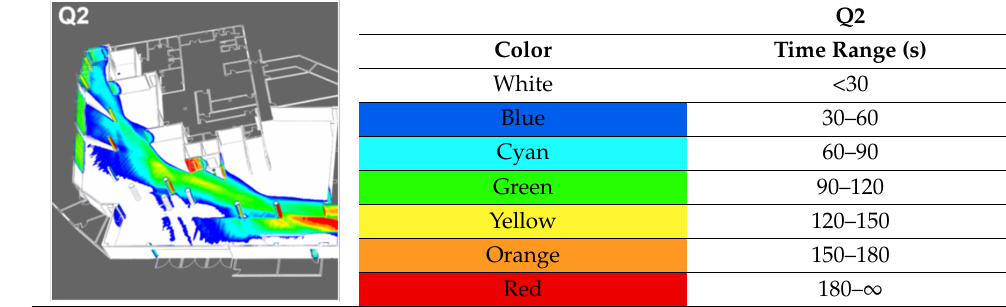
Table 4. Vision time map analysis in Q2.